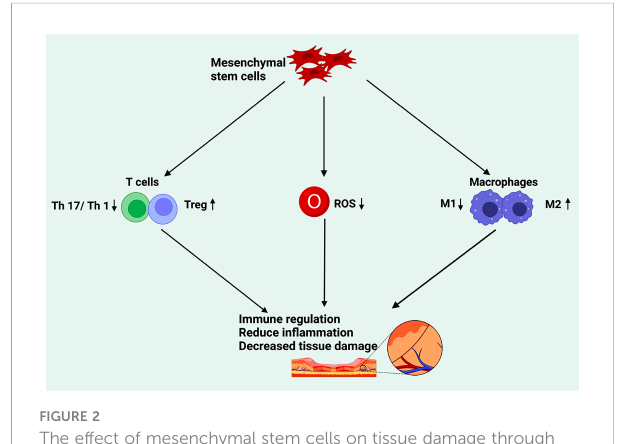
FIGURE 2 The effect of mesenchymal stem cells on tissue damage through immune regulation. Mesenchymal stem cells participate in immune regulation by inhibiting T17 and T1 cells, promoting Treg cells, downregulating ROS, and accelerating the polarization of M2, so as to reduce in fl ammation and repair the damage of diabetic foot. (Created in